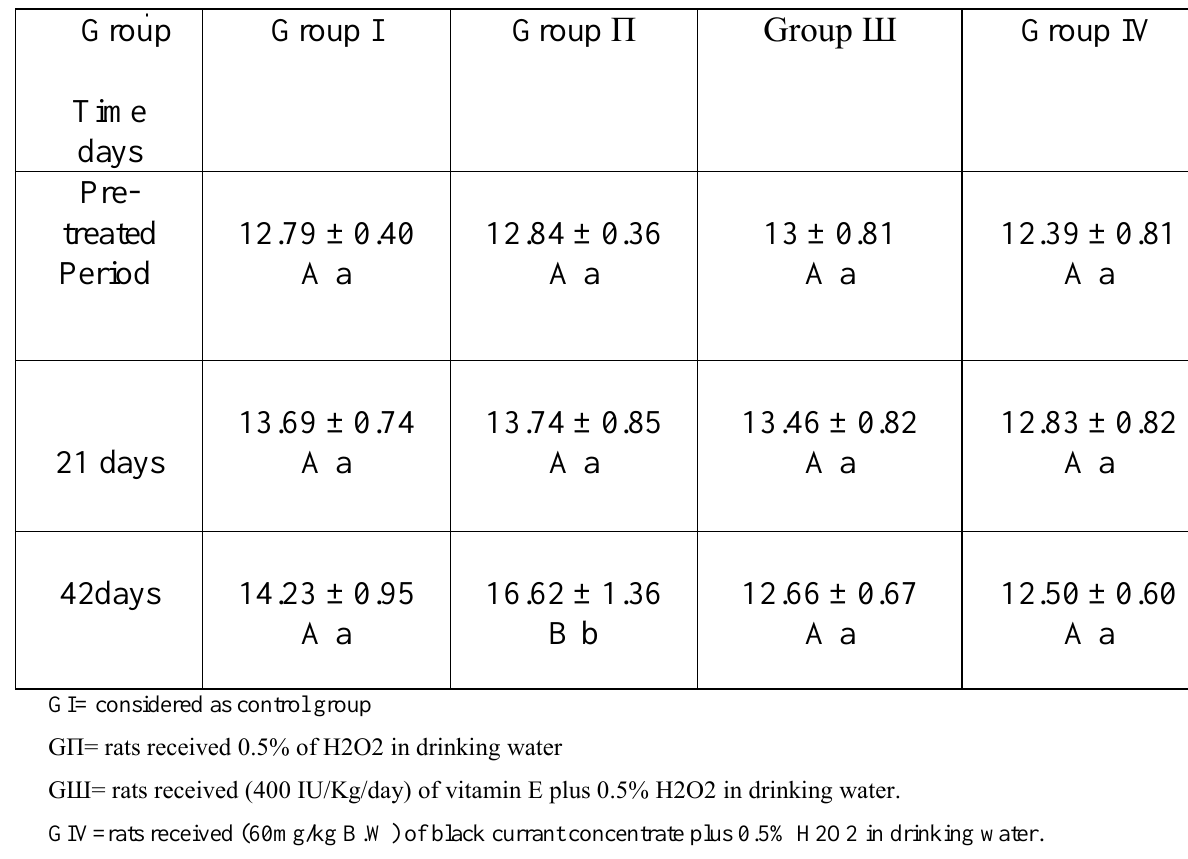
Table (7) Effect of black currant concentrate (Vitis Vinfera.L) and vitamin E on serum very low density lipoprotein cholesterol (VLDL-C) concentration in H2O2 treated